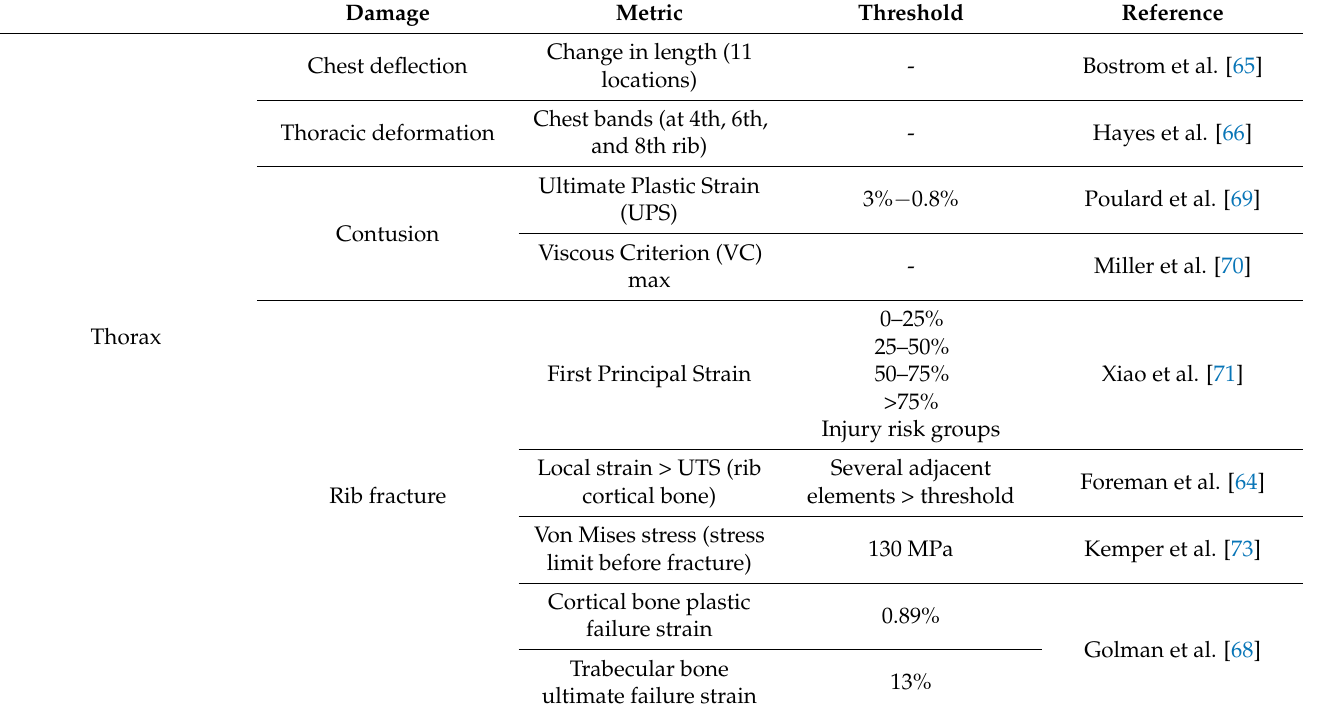
Table 2. Summary of the main IC proposed for the